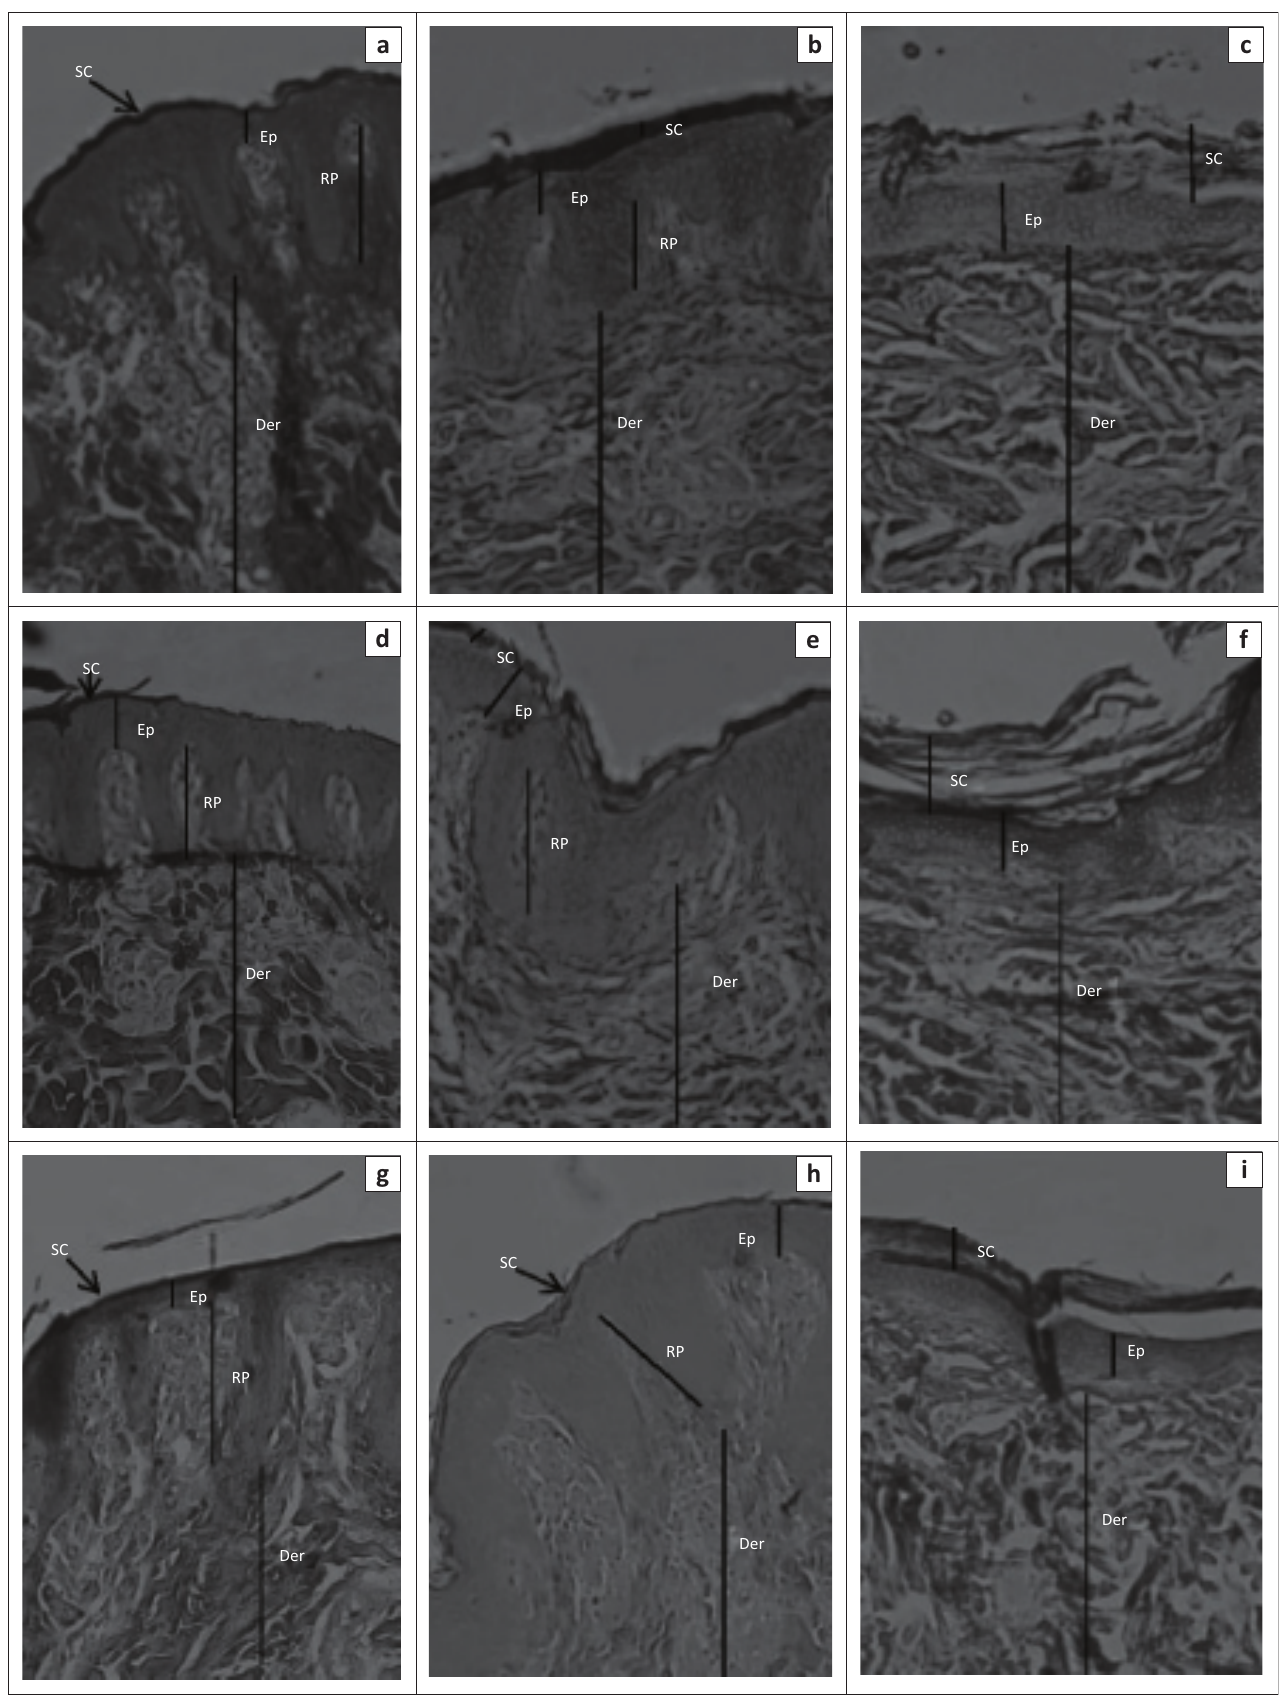
FIGURE 1: Representative skin sections from the (a, b, c) dorsal interscapular region (d, e, f), lateral thoraco-abdominal region and (g, h, i) ventral abdominal region of (a, d, g) Windsnyer (b, e, h), Kolbroek and (c, f, g) Large White pigs. The three sections from the different body regions of the three breeds of pigs show the epidermis (Ep), dermis (Der) and stratum corneum (SC) and rete pegs (RP) (Mallory–Heidenhain stain; objective: